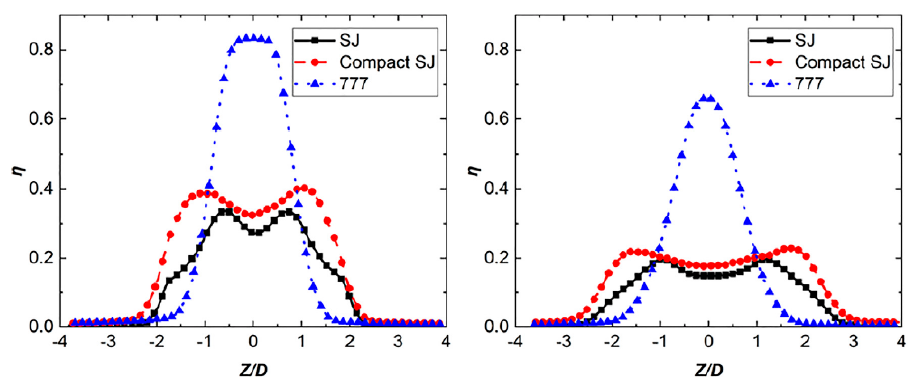
Figure 25. Synthetic jet configurations helped to spread the coolant on the target surface, as shown by the film effectiveness on a flat plate [133].